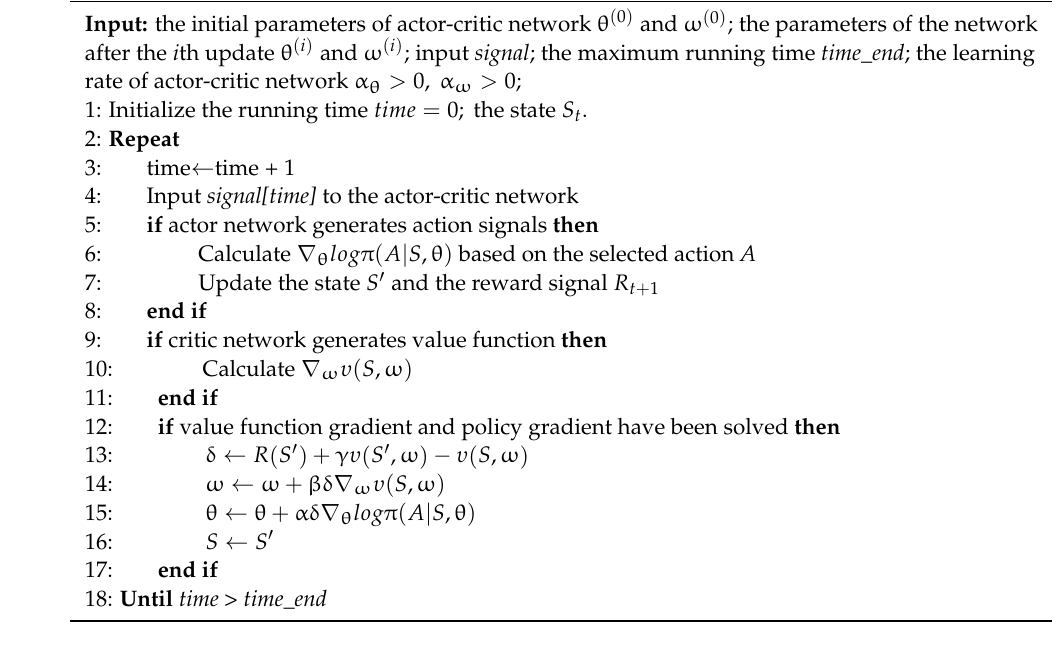
Algorithm 1 Actor-critic network structure with TD